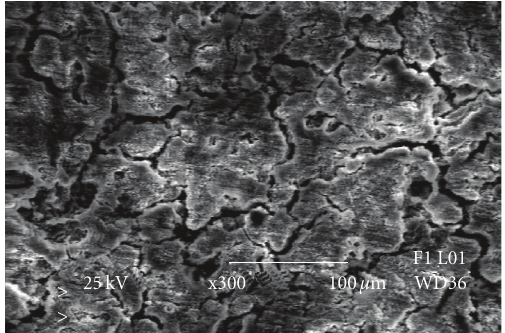
Figure 5: EDAX Analysis of previous Figure 4.